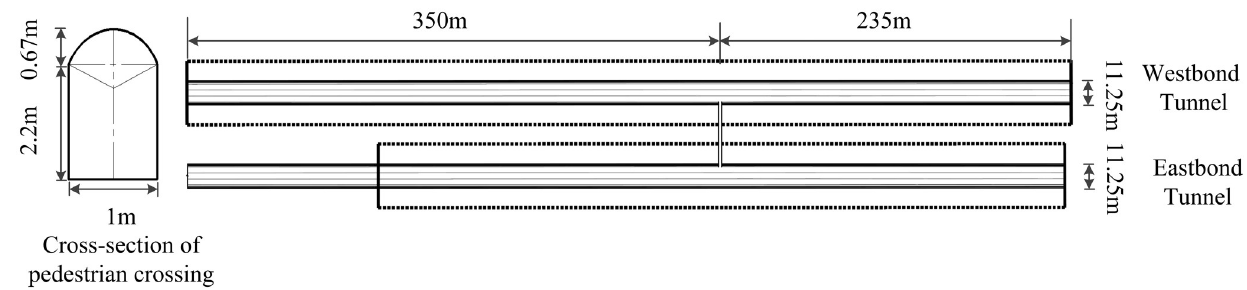
Fig 3. Horizontal and cross section of Maoshan Tunnel.